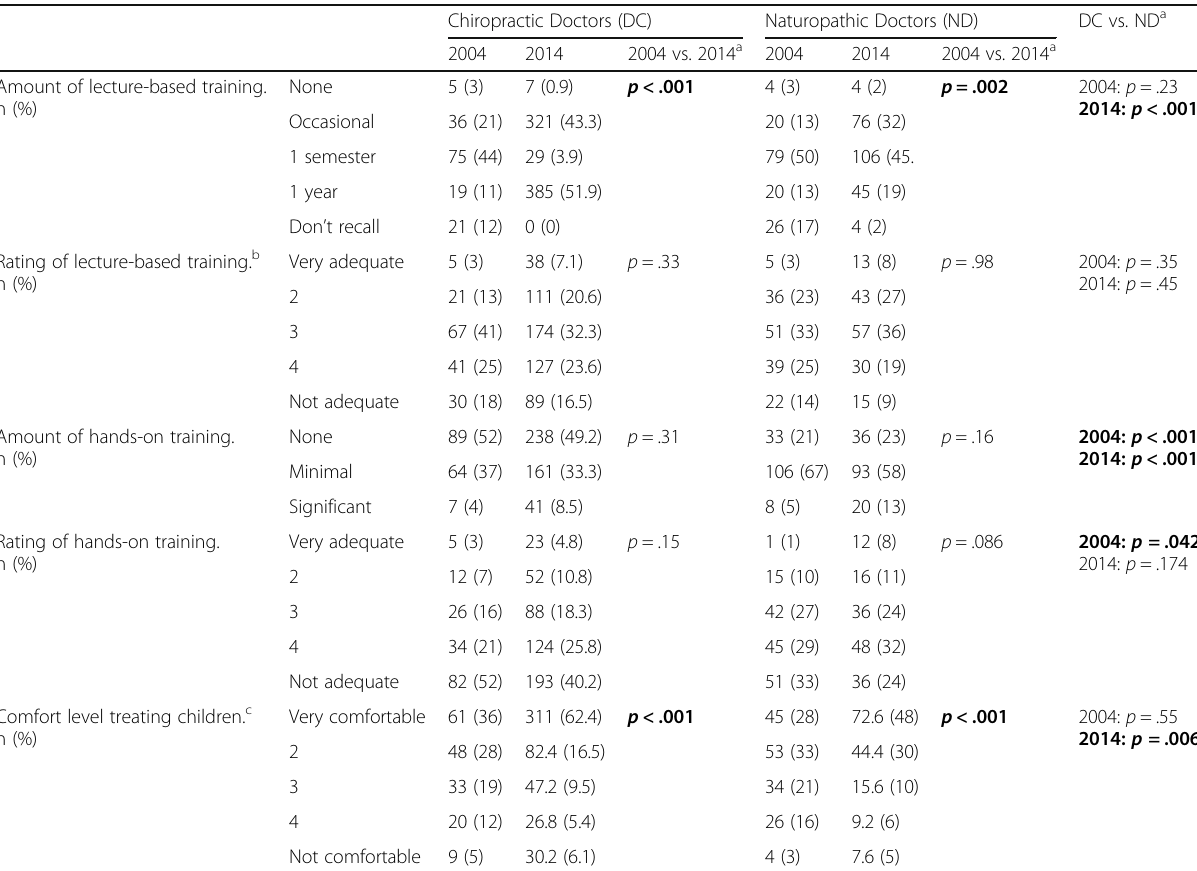
Table 2 Pediatric training